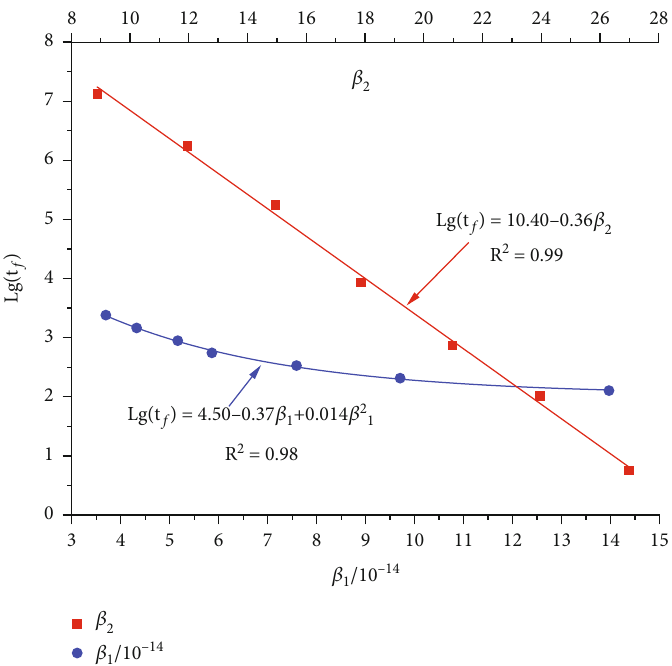
Figure 3: Relationship curves of β